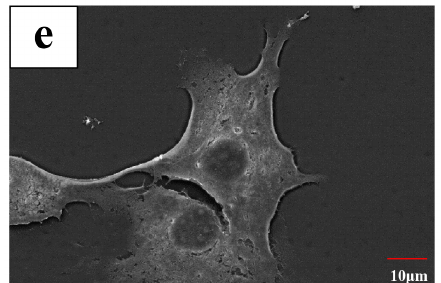
Figure 5. Images of MC3T3-E1 cells cultured on different surfaces after 24 h of culture by SEM observed at 1000 × , scale bar, 10 µ m: ( a ) Ti; ( b ) Ti-PLGA, pure Ti with PLGA coating; ( c ) NT, TiO 2 nanotubes; ( d ) NT-ICA, TiO 2 nanotubes loading icariin; ( e ) NT-ICA-PLGA, icariin-functionalized coating on TiO 2 nanotubes surface. The representative images of three independent experiments were displayed.